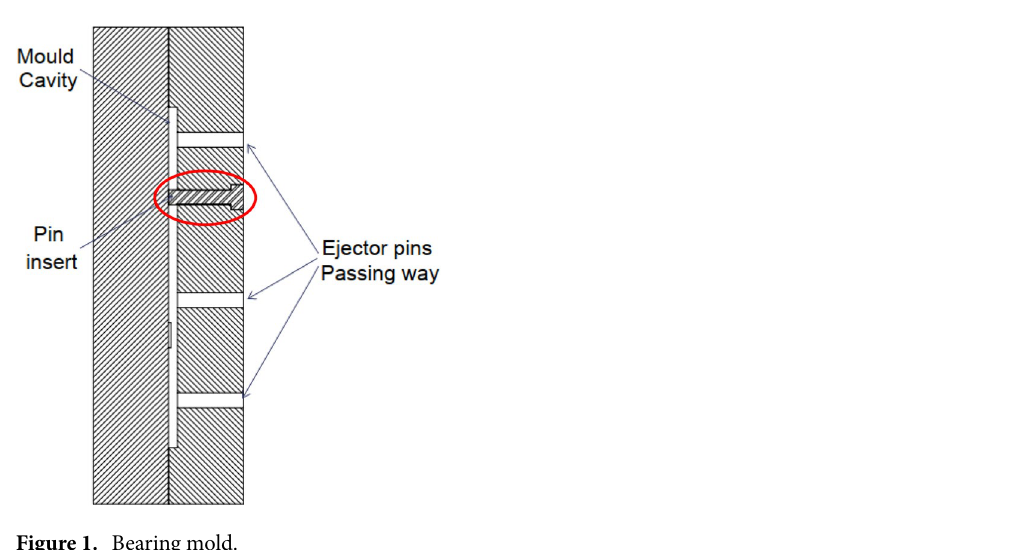
Figure 1. Bearing